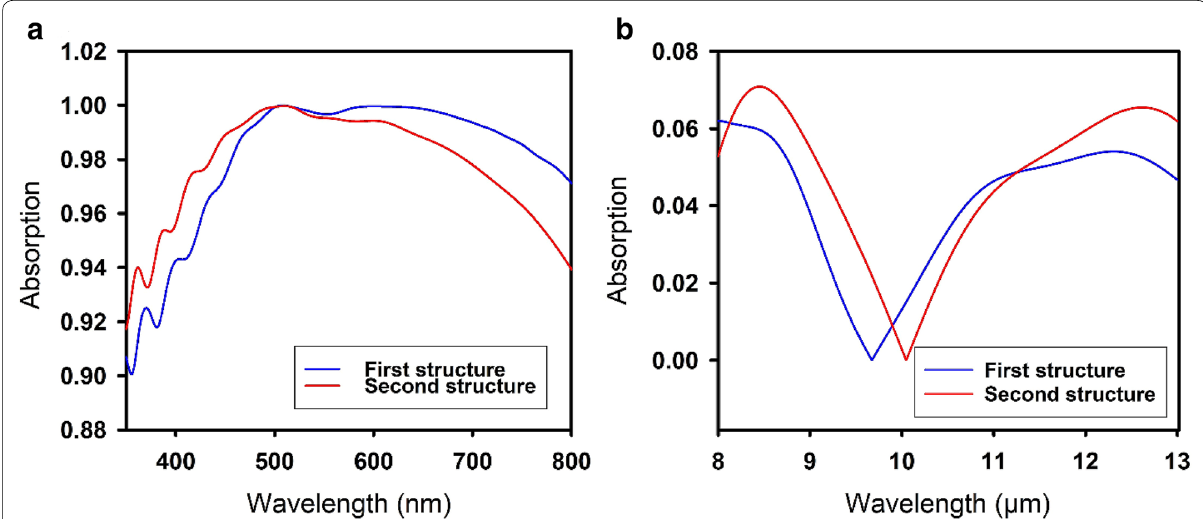
Fig. 4 Absorption curves of the top two performing structures from Table 3 for ( a ) 350–800 nm and ( b ) 8–13